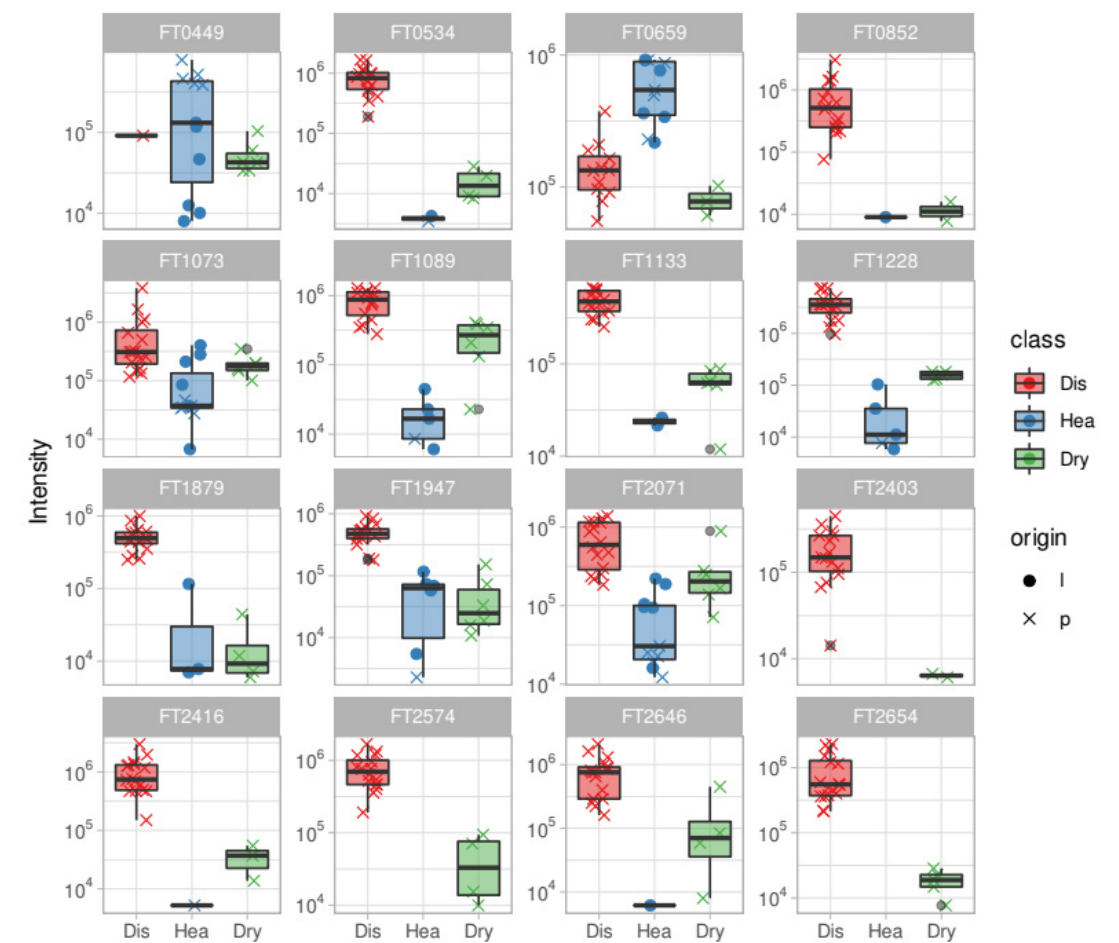
Figure 4. Boxplots for the annotated features; abundances are reported for each class together with the origin factor. Red boxes represent the diseased samples, blue boxes the healthy samples and green boxes the dried samples.